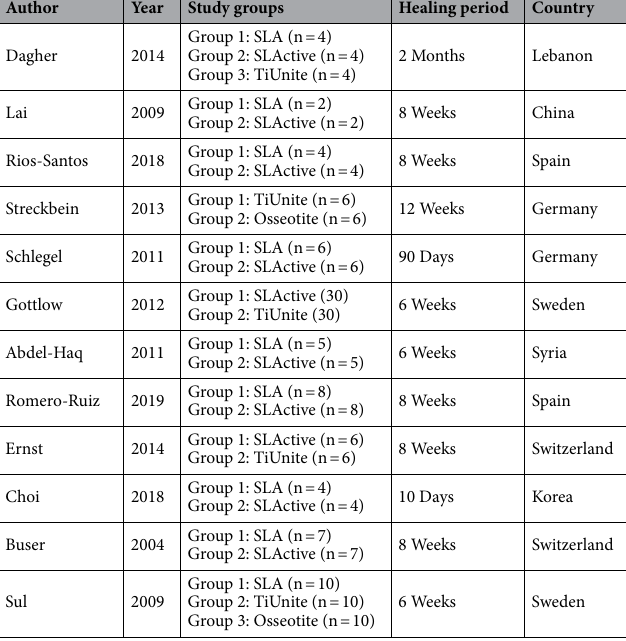
Table 2. The characteristics of included